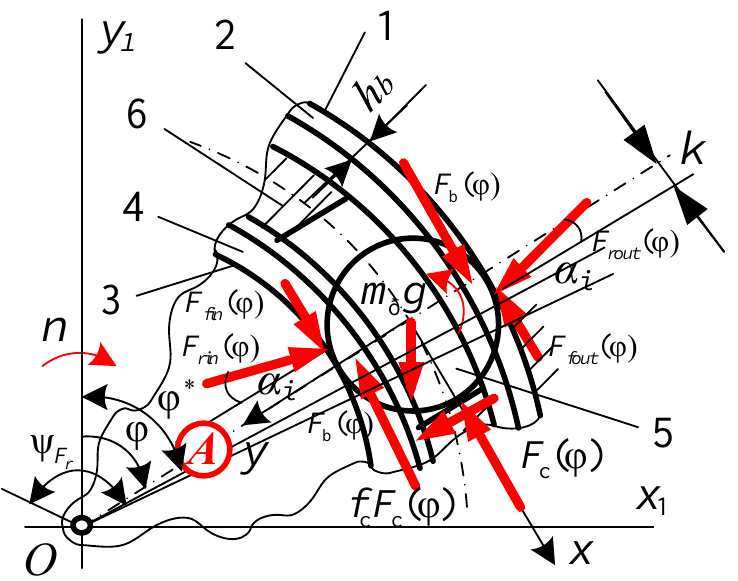
Figure 2. The scheme of force interactions in zone A: 1, 2 — outer ring and a rib; 3, 4 — inner ring and a rib; 5 — rolling body; 6 — cage.